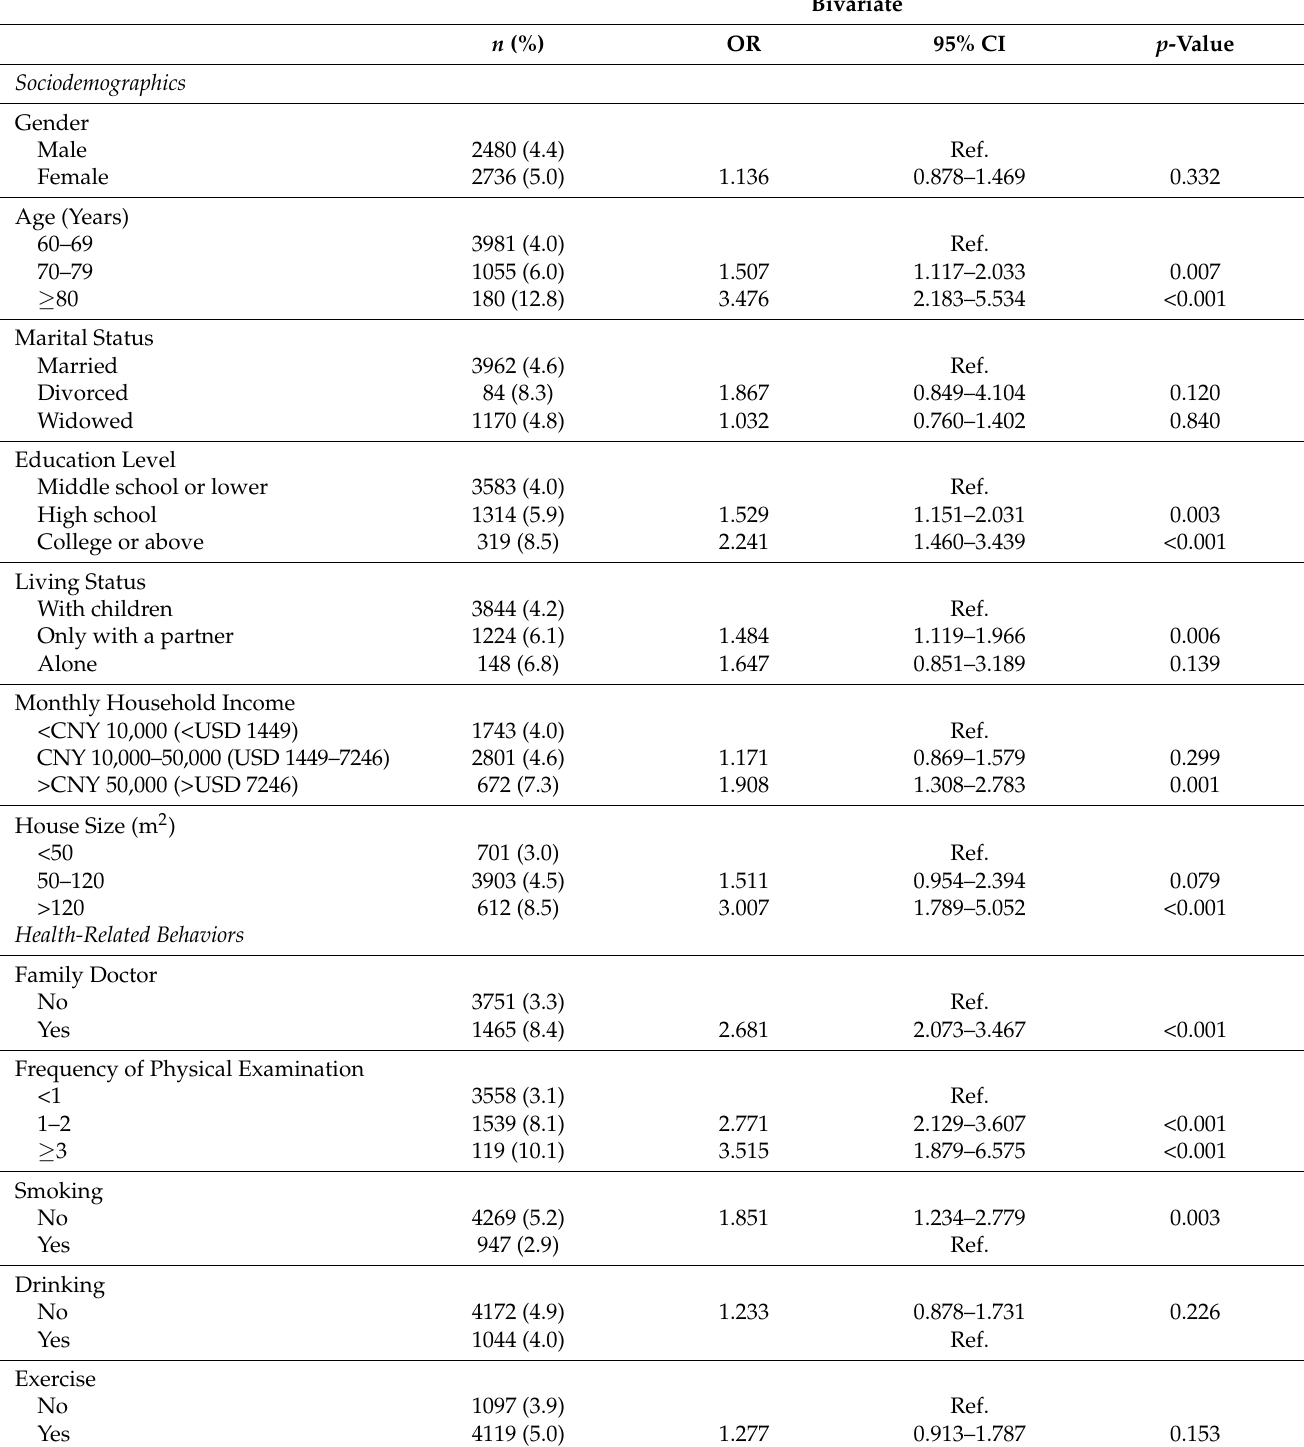
Table 2. Factors for influenza vaccination among the elderly with